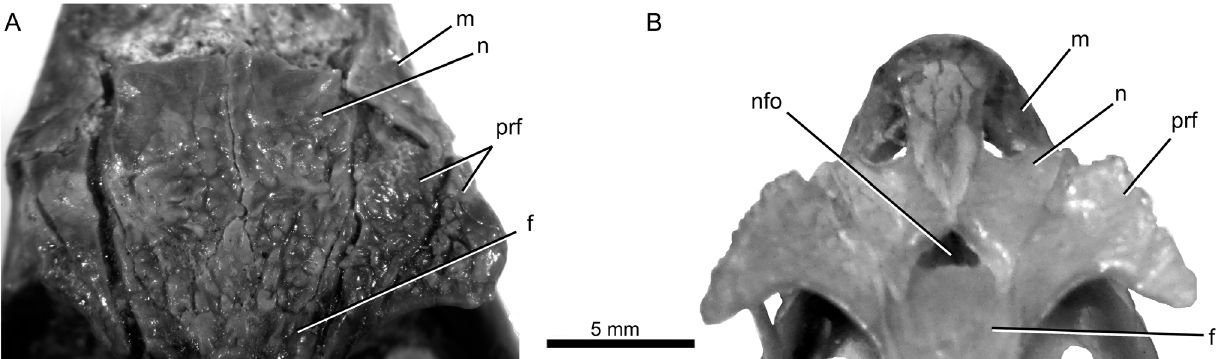
Fig 2. Comparison of the nasal and prefrontal regions of (A) Babibasiliscus alxi nov. taxon (UWBM 89090)and (B) Corytophanes hernandezi (AMNH R 147880) in dorsal